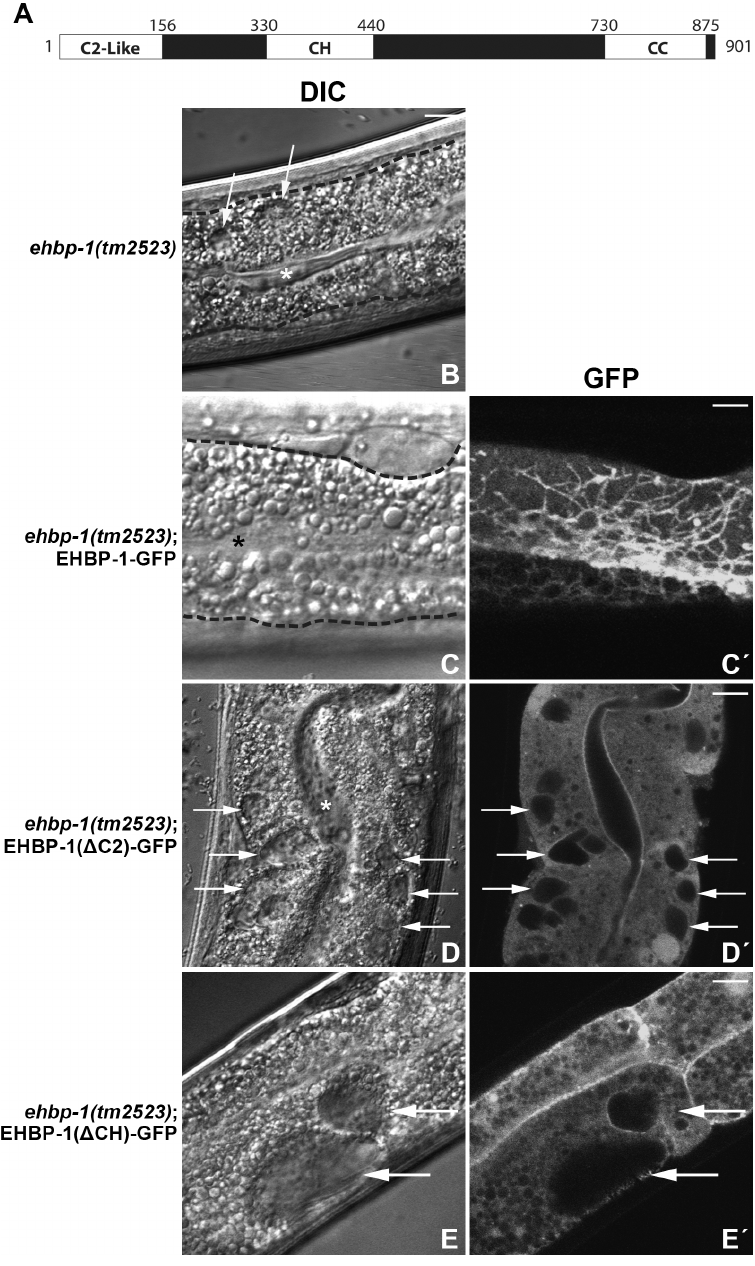
Fig 1. EHBP-1 lacking the N-terminal C2-like or central CH domain failed to rescue the vacuolated phenotype in the C . elegans intestine. (A) Schematic representation of EHBP-1 sequence regions including the N-terminal C2-like domain (NT-C2), internal CH (Calponin Homology) domain and C-terminal coiled-coil (CC) domain. Protein domains are displayed as white boxes and amino acid numbers are indicated. (B) In ehbp-1(tm2523) deletion mutant intestinal cells, abnormally enlarged vacuoles can be observed by DIC microscopy. (C-C') The vacuolated intestine phenotype can be fully rescued by expression of EHBP-1-GFP. (D-D') Many large vacuoles can still be observed in animals expressing EHBP-1 lacking the NT-C2 domain. (E-E') Expression of EHBP-1 lacking the CH domain failed to rescue the vacuolated intestine phenotype. Tissue boundaries of intestines are outlined in (B and C) . Arrows indicate vacuolated structures in the intestinal cells. Asterisks indicate intestinal lumens. Scale bars represent 10 μ m.